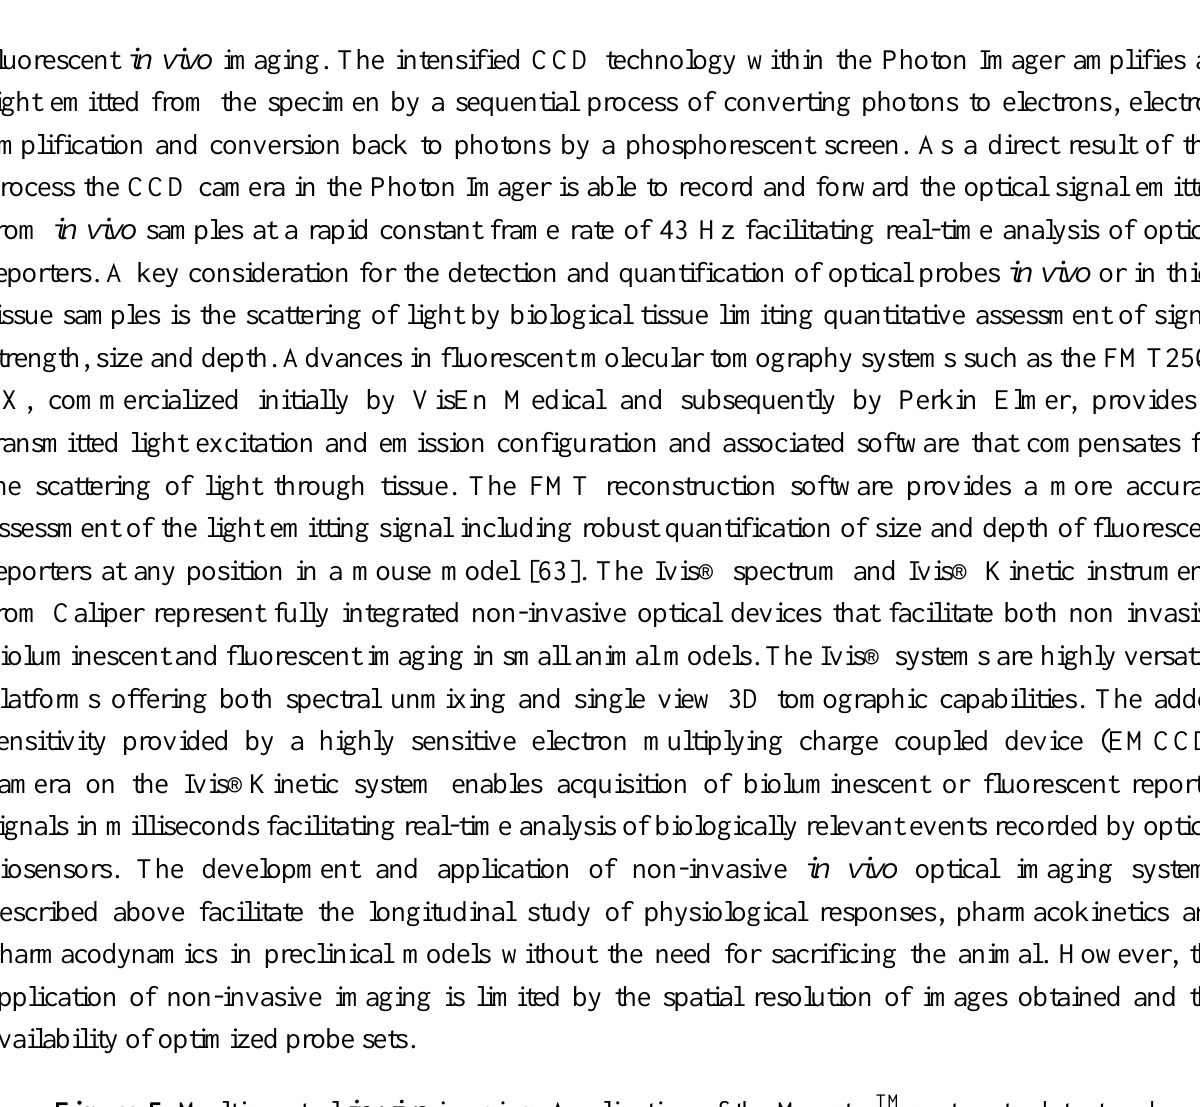
Figure 5. Multispectral in vivo imaging. Application of the Maestro TM system to detect and differentiate RFP labeled MDA-MB231 breast cancer cells in a live mouse following orthotopic implantation in the mammary fat